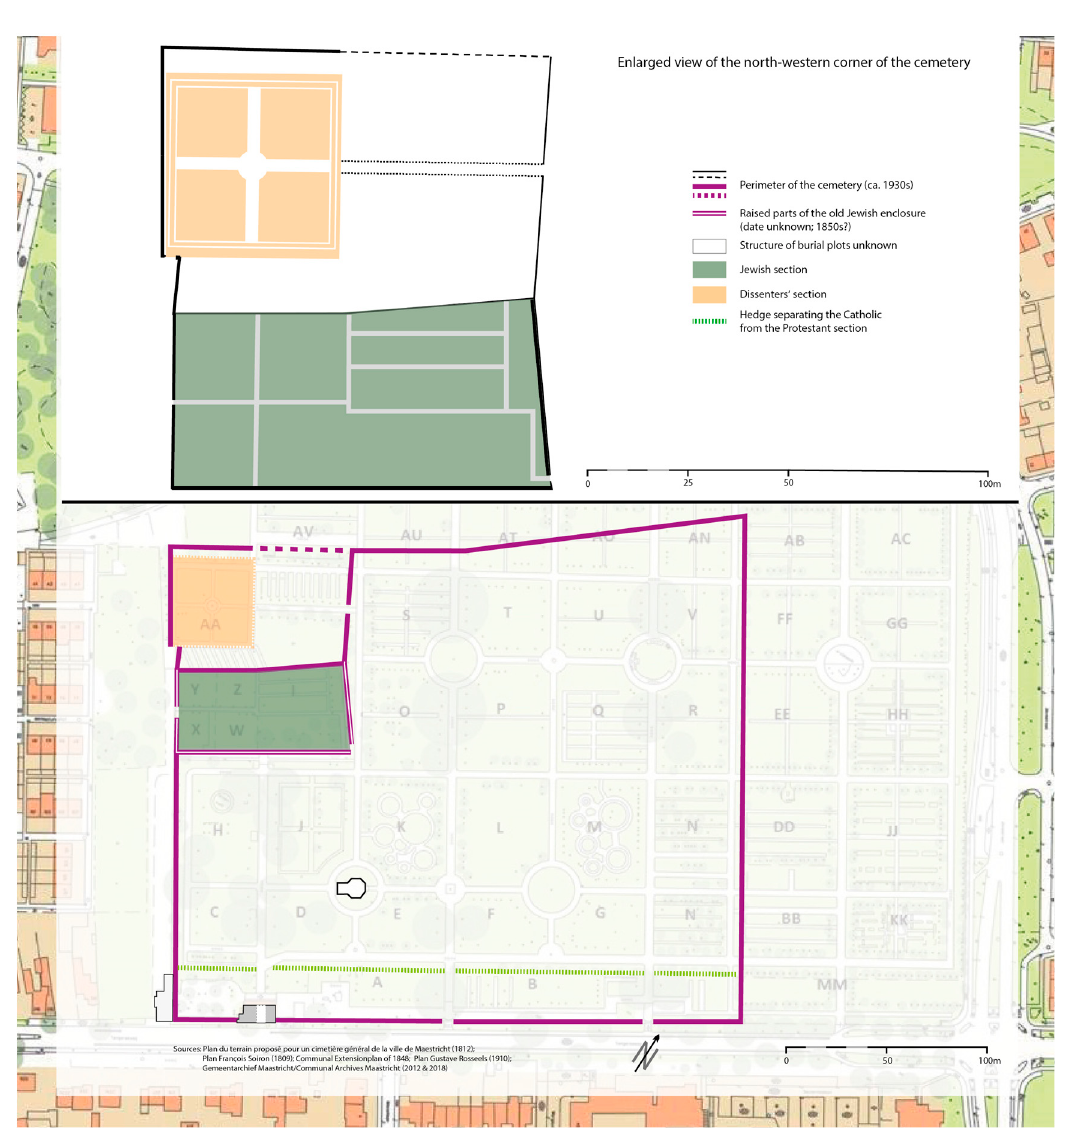
Figure 4. Schematic map indicating the section for dissenters (T.K.).